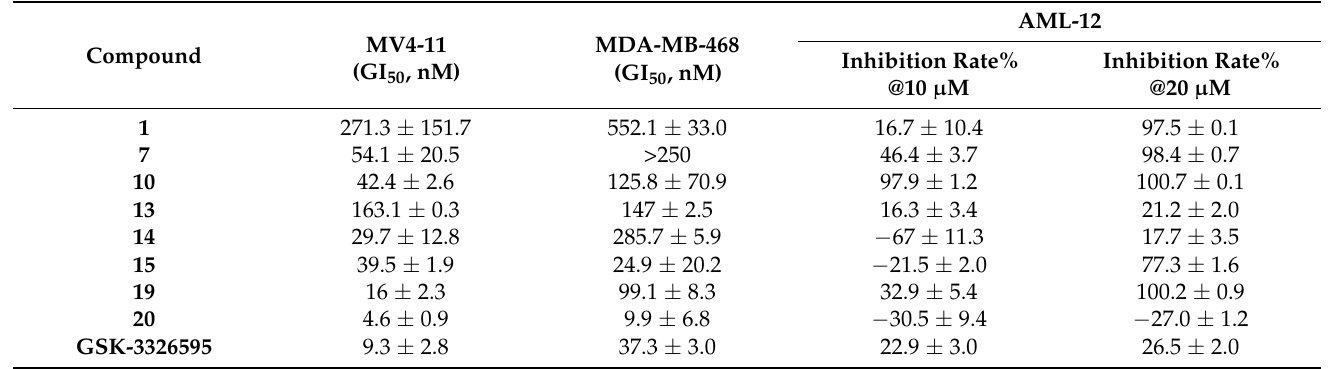
Table 3. Anti-proliferative activity of compounds in vitro.